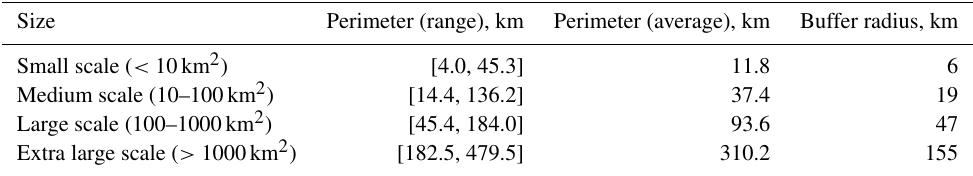
Table 3. Parameters used to define the calving recurrence